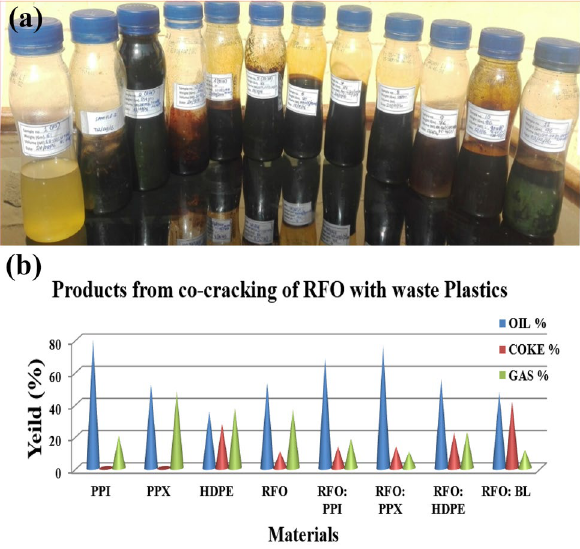
Figure 1. ( a ) Liquid product obtained from the co-cracking of RFO and waste plastics. ( b ) Graphical representation of products yield distribution from the binary co-cracking of RFO with